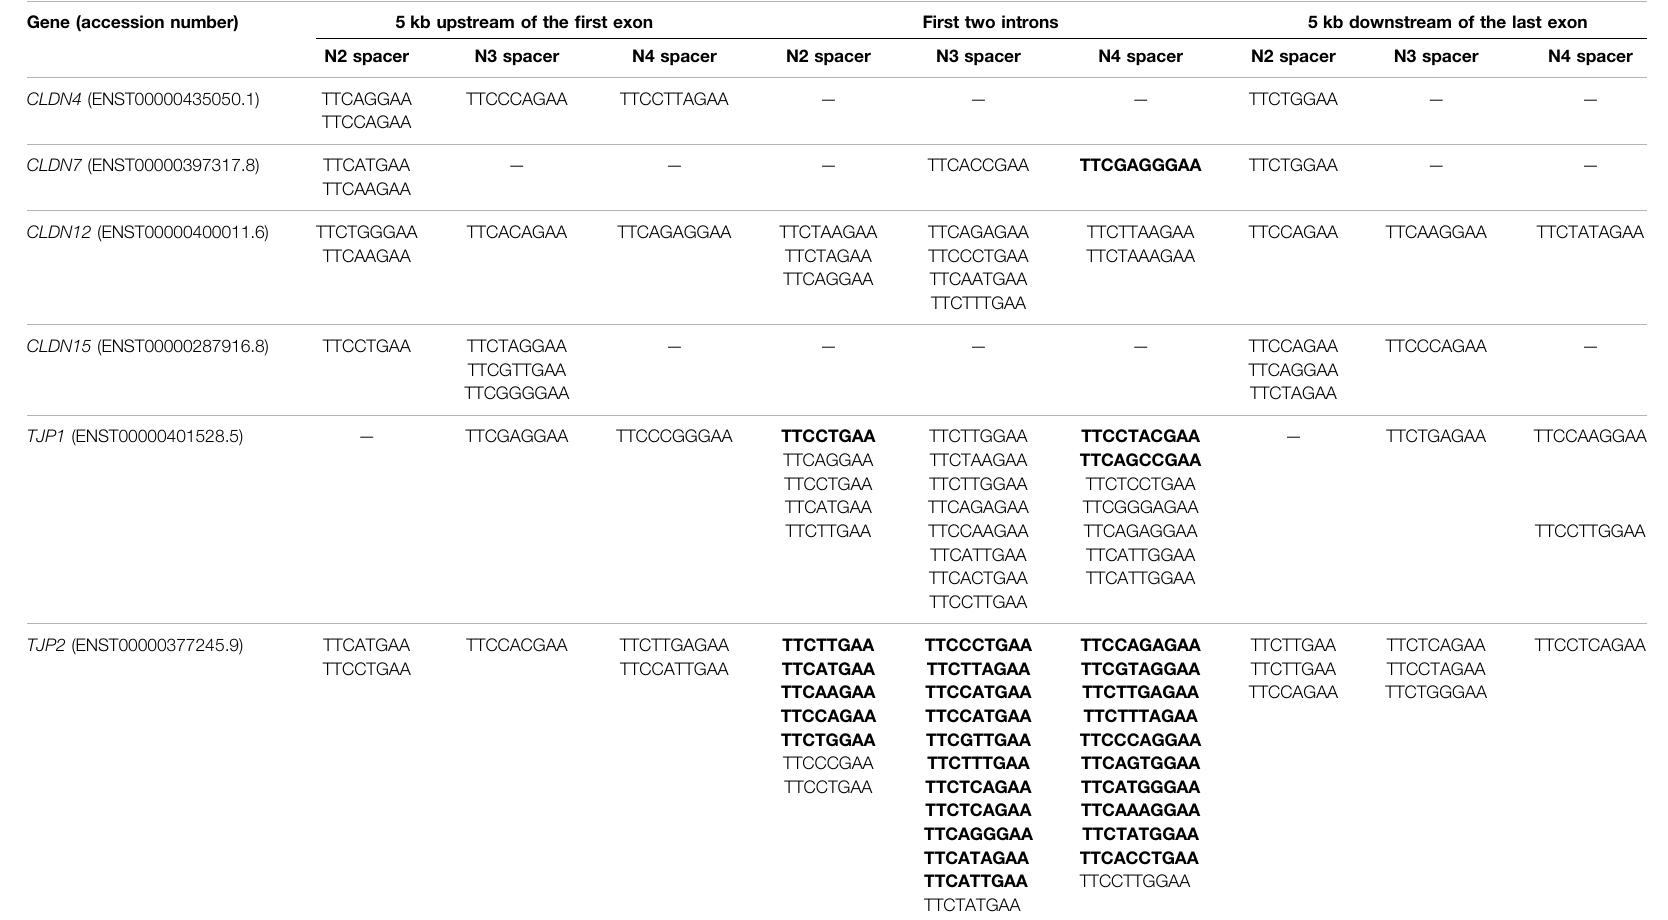
TABLE 1 | Presence of STATs consensus sequence 5 ′ -TTC(N) 2-4 GAA-3 ′ in DNA regions of TJ genes. Motif within intron 1 is in bold. Gene (accession